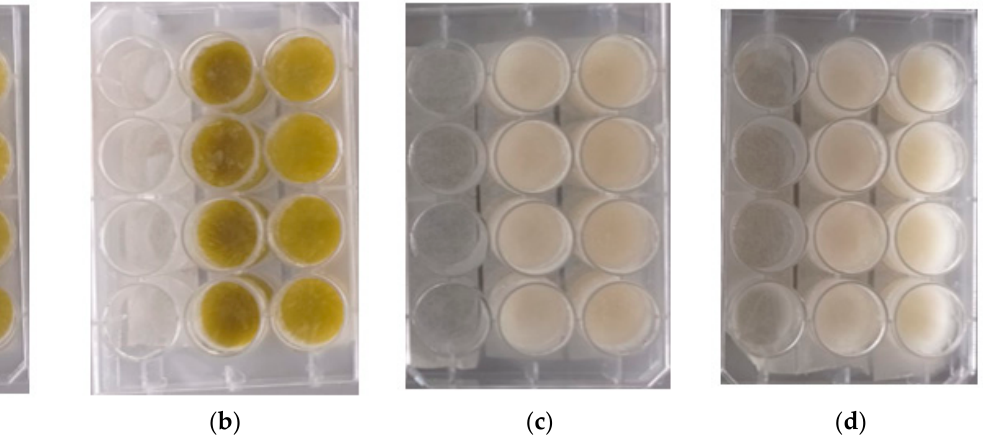
Figure 9. Cellulose hydrogel after encapsulation of Eupatorium glutinosum Lam. Extract ( a ) EG − methanolic and ( b ) EG − ethanolic, while ( c ) corresponds to before encapsulation, WE/NRC, and ( d ) to WE/MCC.